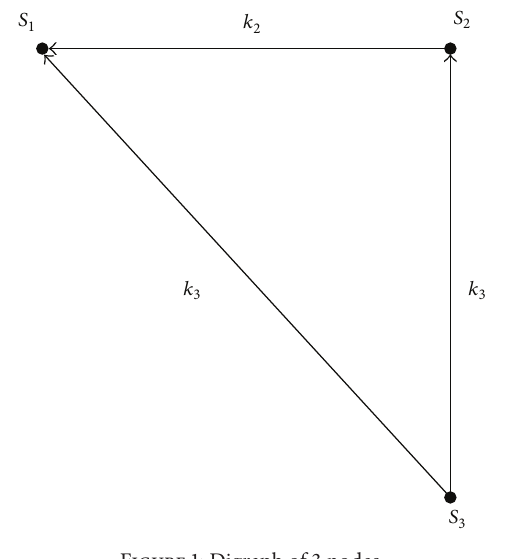
Figure 3: Performance with identical ( 𝑒 (1) (𝑡) ; black line) and nonidentical ( 𝑒 (2) (𝑡) ; blue line) gains.